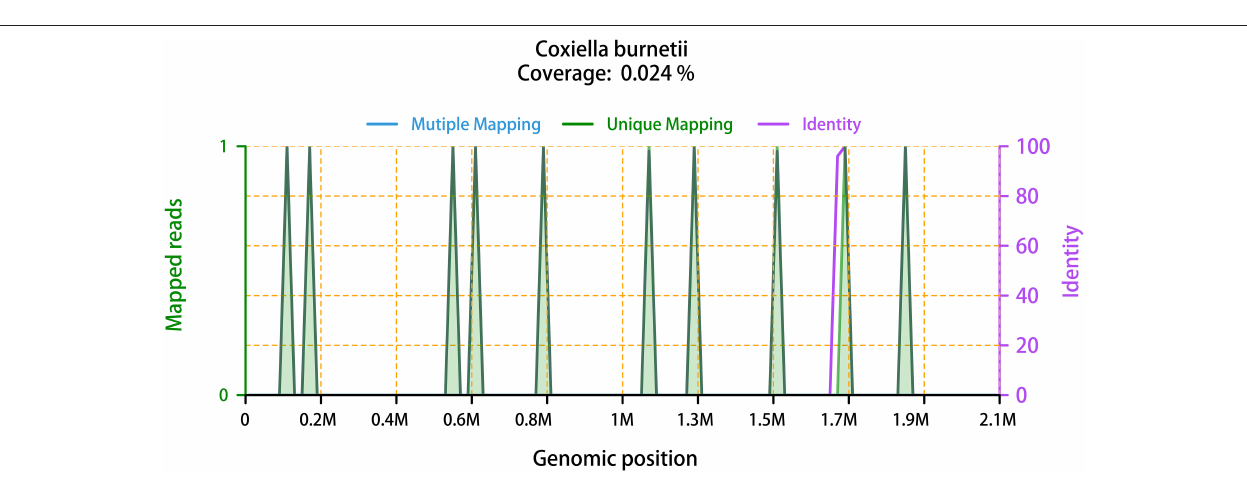
500 bp, covering 0.024% of the C. burnetii genome ( Figure 2